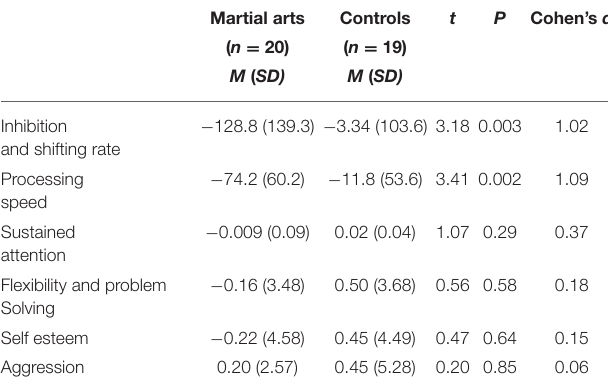
TABLE 2 | Mean change-score comparisons between martial arts training and controls on outcome